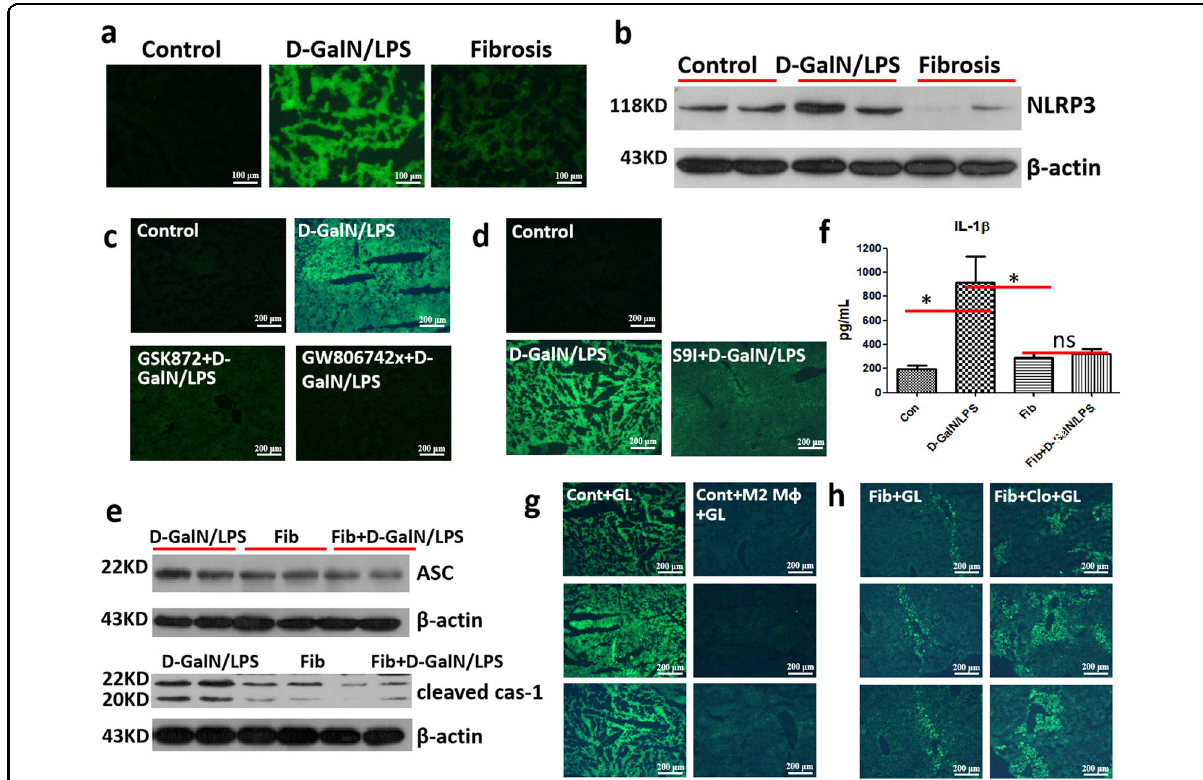
Fig. 5 M2-like macrophages in the fi broic liver inhibit necroptosis- and S100A9-dependent NLRP3 in fl ammasome activation and ensuing necroin fl ammation. Comparison of NLRP3 expression in control, acutely injured, and fi brotic mice by immuno fl uorescence ( a ) and western blot ( b ) analysis. The expression of NLRP3 in mice receiving RIPK3 or MLKL inhibitor ( c ) and S100A9 inhibitor ( d ) followed by acute insult. e The expression of necroin fl ammation markers ASC and cleaved Caspase-1 in acutely injured mice and fi brotic mice with or without acute insult. f The expression of proin fl ammatory cytokine IL-1 β in control and fi brotic mice with or without acute insult ( n = 5 – 9). g Comparison of the expression of NLRP3 (upper), ASC (middle), and cleaved caspase-1 (lower) in acutely injured mice with or without M2-like macrophage transfer. h Comparison of the expression of NLRP3 (upper), ASC (middle), and cleaved caspase-1 (lower) in fi brotic mice upon acute insult with or without M2-like macrophage